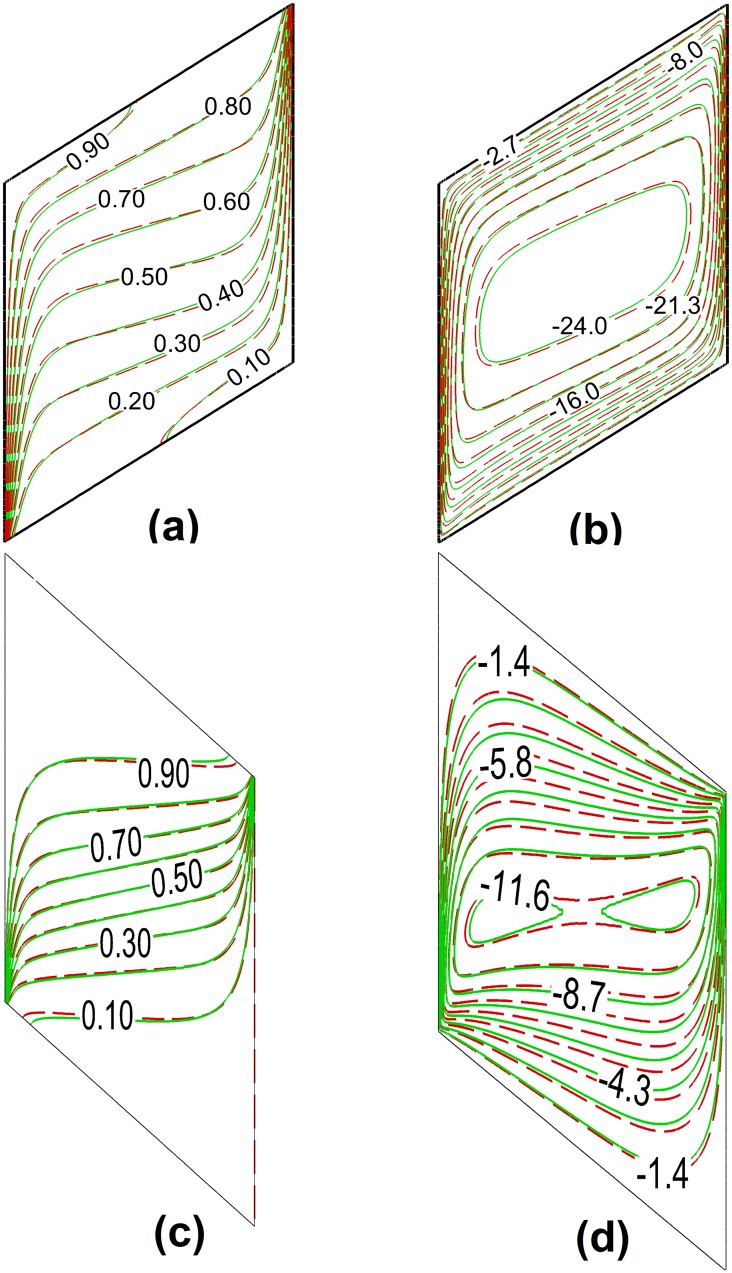
A comparison between isotherms (a), (c) and streamlines (b), (d) of the nanofluid and base fluid in a glass balls porous medium for two inclination angles of α = - 60° and α = + 60° when Ra = 1000, A = 1, φ = 0.05 and ε = 0.5; the dashed red lines are base fluid and the solid green lines are the nanofluid.